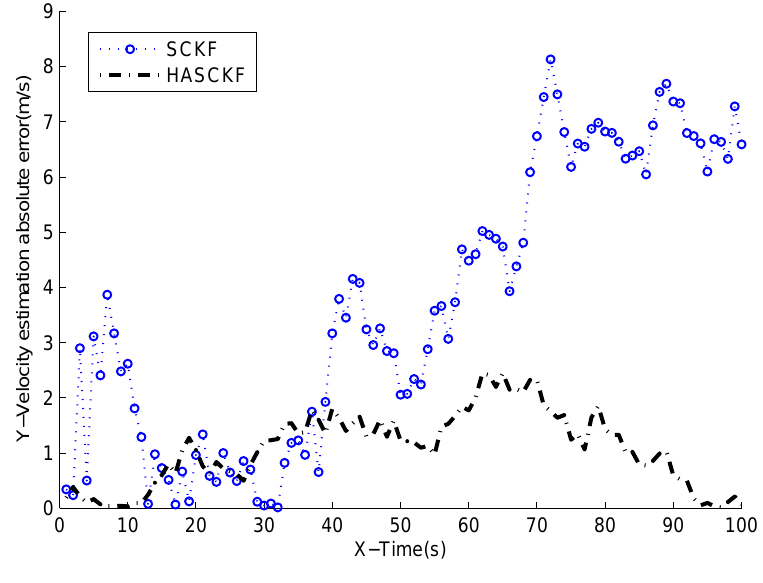
Figure 10. Absolute error curves of